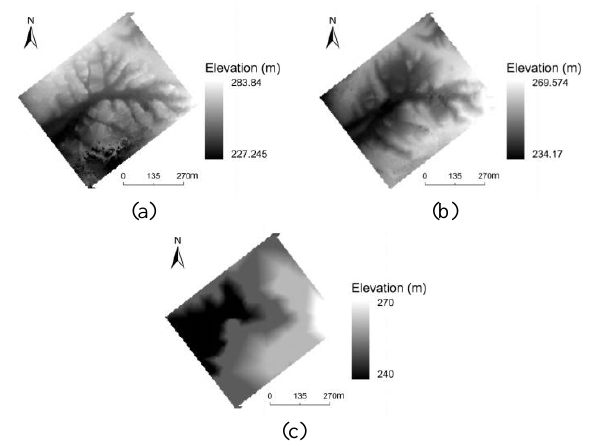
Figure 4. UAV-DEM georeferenced by (a) POS acquired by UAV, and by (b) GCPs, (c) Contour-DEM.